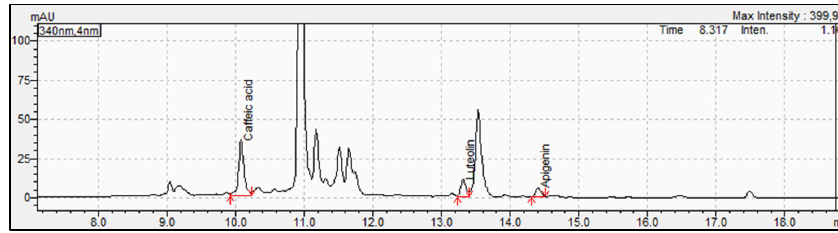
Figure 1. Representative chromatogram acquired for parsley sample extract at 340 nm.